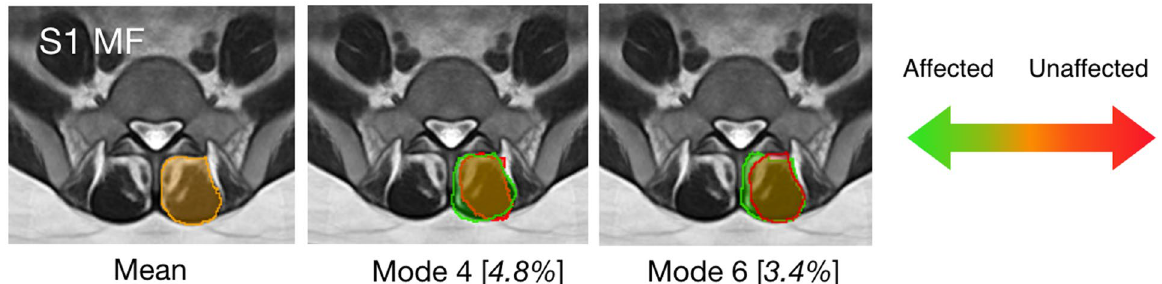
Figure 3. Modes of the multifidus (MF) shape that were associated with the disc herniation at S1. The mean shape is shown in orange overlaid on the population-averaged MRI template. The trend of shape variation towards the muscle being affected is in green and the opposite is in red. For each mode, threefold standard deviations from the mean shape are depicted for both directions of shape variants, and the percentages of shape variance explained are included in [ ] for all modes.